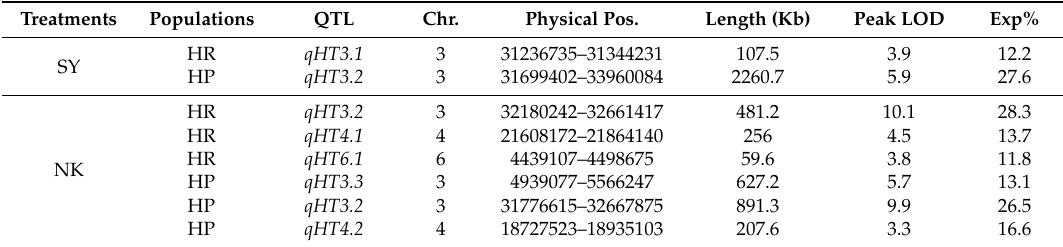
Table 2. QTLs for thermotolerance that were identified in RIL and DH populations in two heat stress treatments.